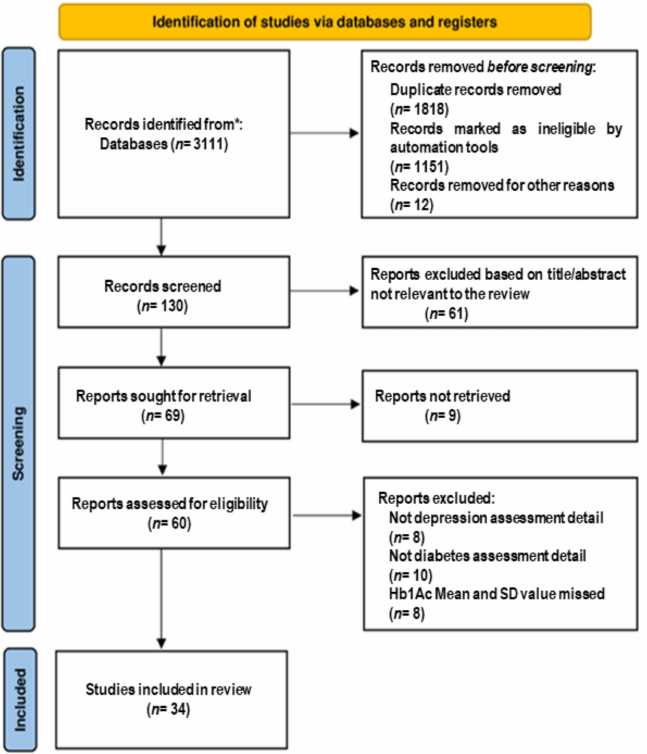
Figure 1. Flowchart showing the different phases in the systematic review and